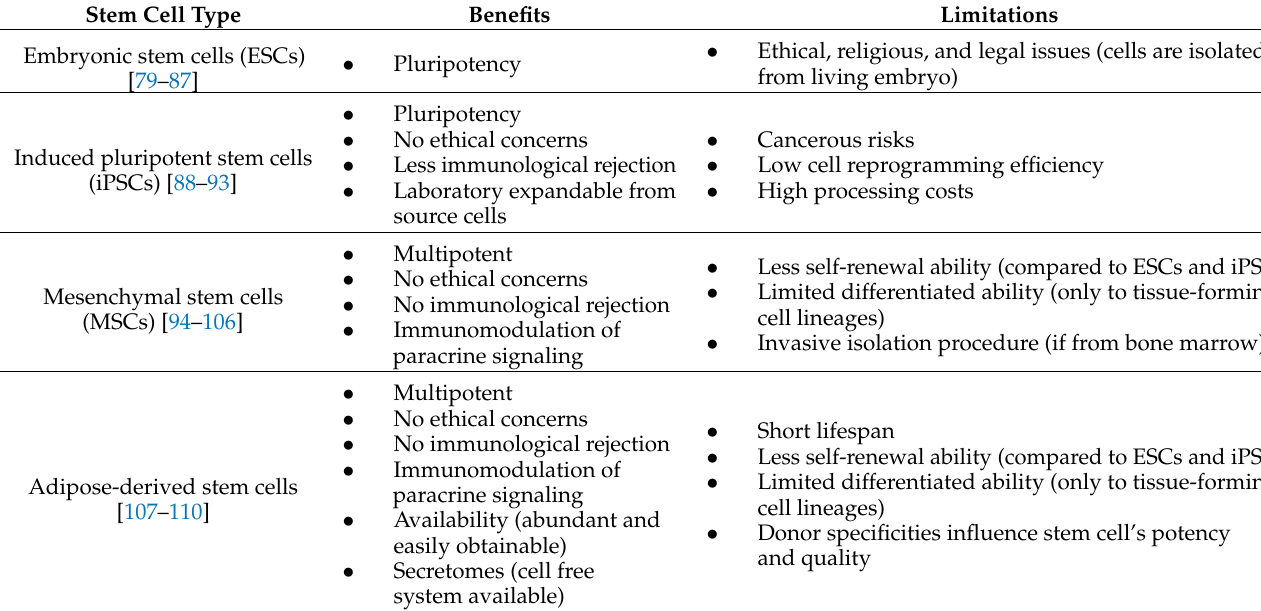
Table 2. Benefits and limitations of various types of stem cell in diabetic wound healing. (Numbers in the parentheses denote the reference